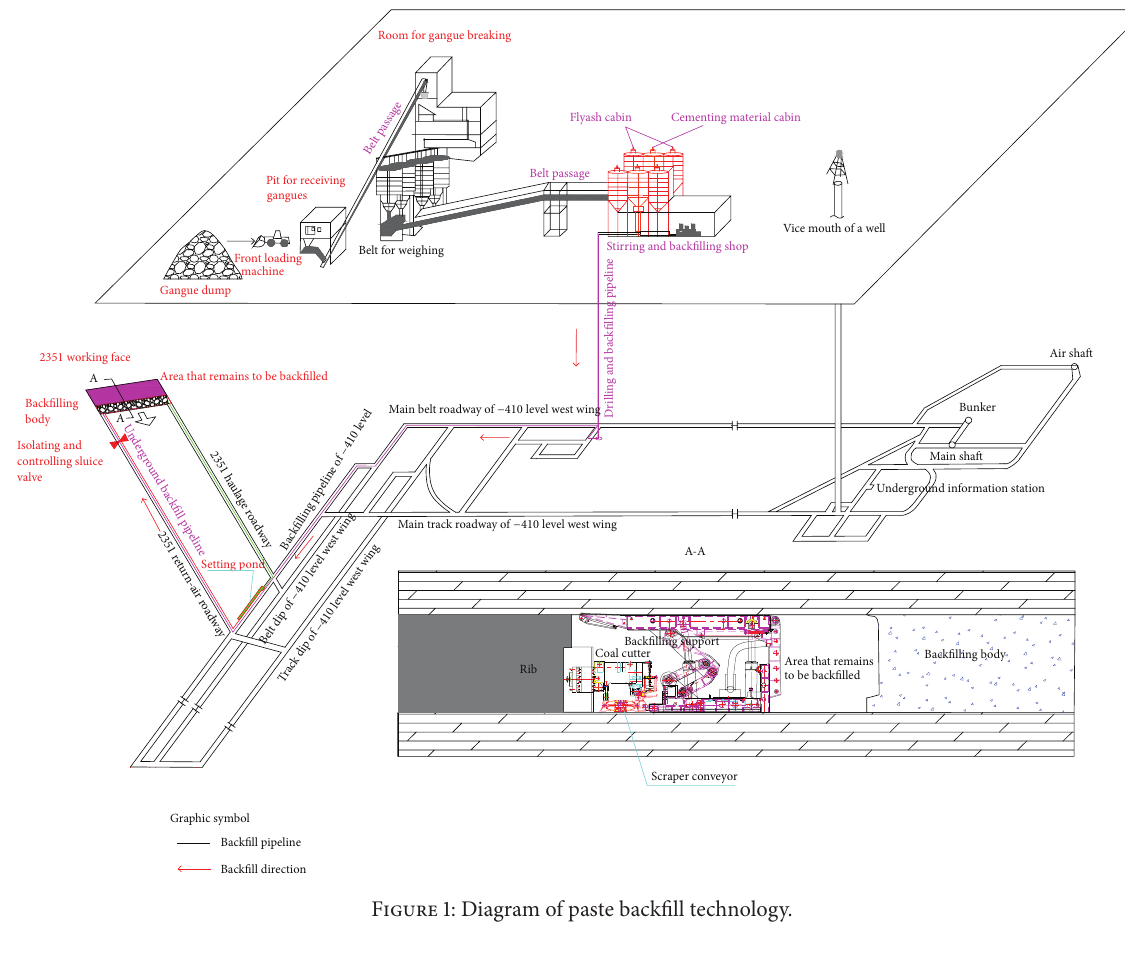
Figure 1: Diagram of paste backfill technology.